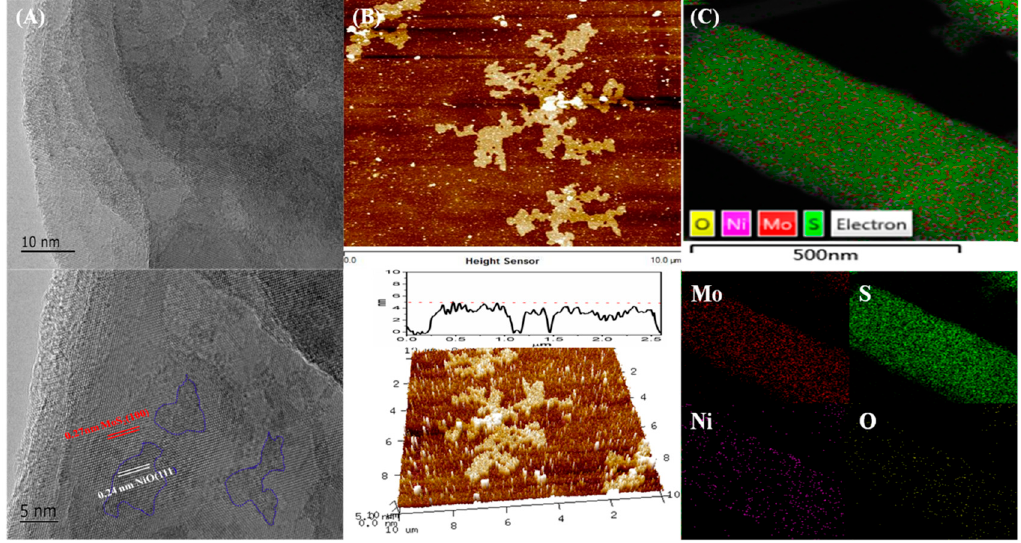
Figure 3. ( A ) HRTEM image of MoS 2 :NiO-3:1; ( B ) AFM of MoS 2 :NiO-3:1; ( C ) elemental mapping of MoS 2 :NiO-3:1, showing a clear uniform distribution of Mo (red), S (green), Ni (purple), and O (yellow). Scale bars are all 500 nm.